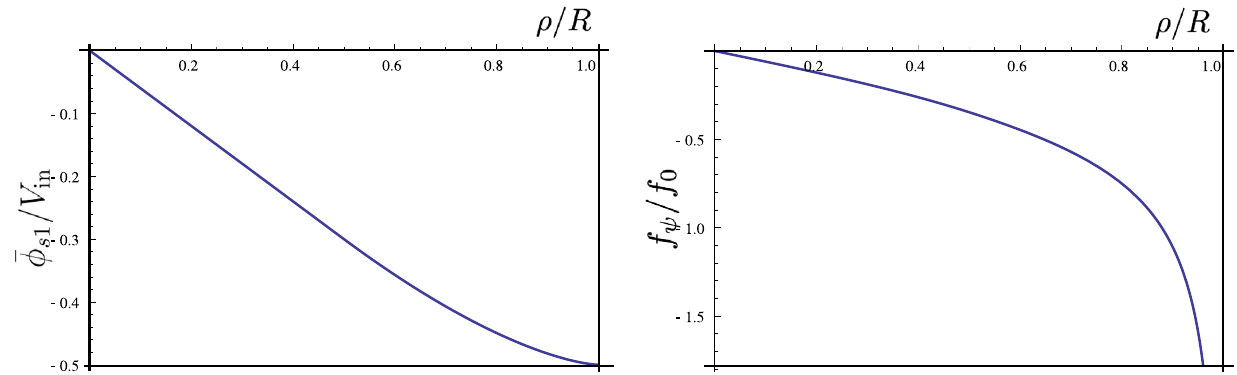
Figure 2. Left: Contribution to the surface potential ¯ φ s 1 / V in is plotted in terms of ρ/ R , distance from the center. Right: Angular component of force f ψ = f b · ˆ ψ scaled by f 0 = ( 8 ǫ 0 /π) E ex ( V in / R ) is plotted in terms of ρ/ R at ψ = π/